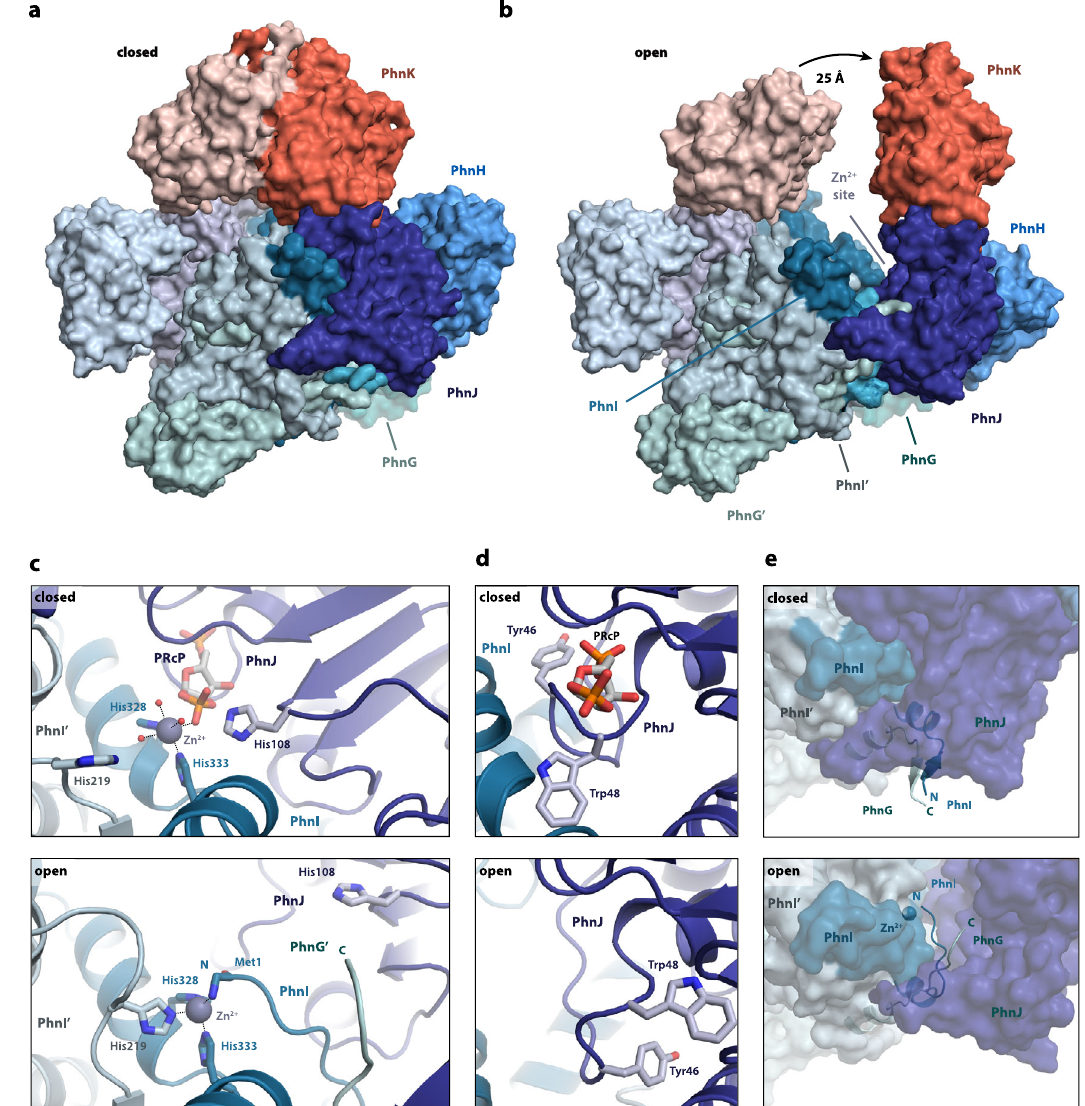
Fig.4|ATPhydrolysisbyPhnKleadstoopeningoftheC – Plyasecorecomplex. Overview of the structural changes taking place in the Phn(GHIJK) 2 complex betweentheclosed( a )andopen( b )states.ThePhn(GHIJK) 2 complexisshownasa surfacerepresentationwiththeC – Plyasecorecomplexinshadesofblue/greenand PhnK in red/light red. The arrow indicates the extent of opening at the Zn 2+ site. c Details of the presumed active site at the interface between PhnI and PhnJ in the closed (top) and open (bottom) states. The Zn 2+ ion isshown asa grey sphere with